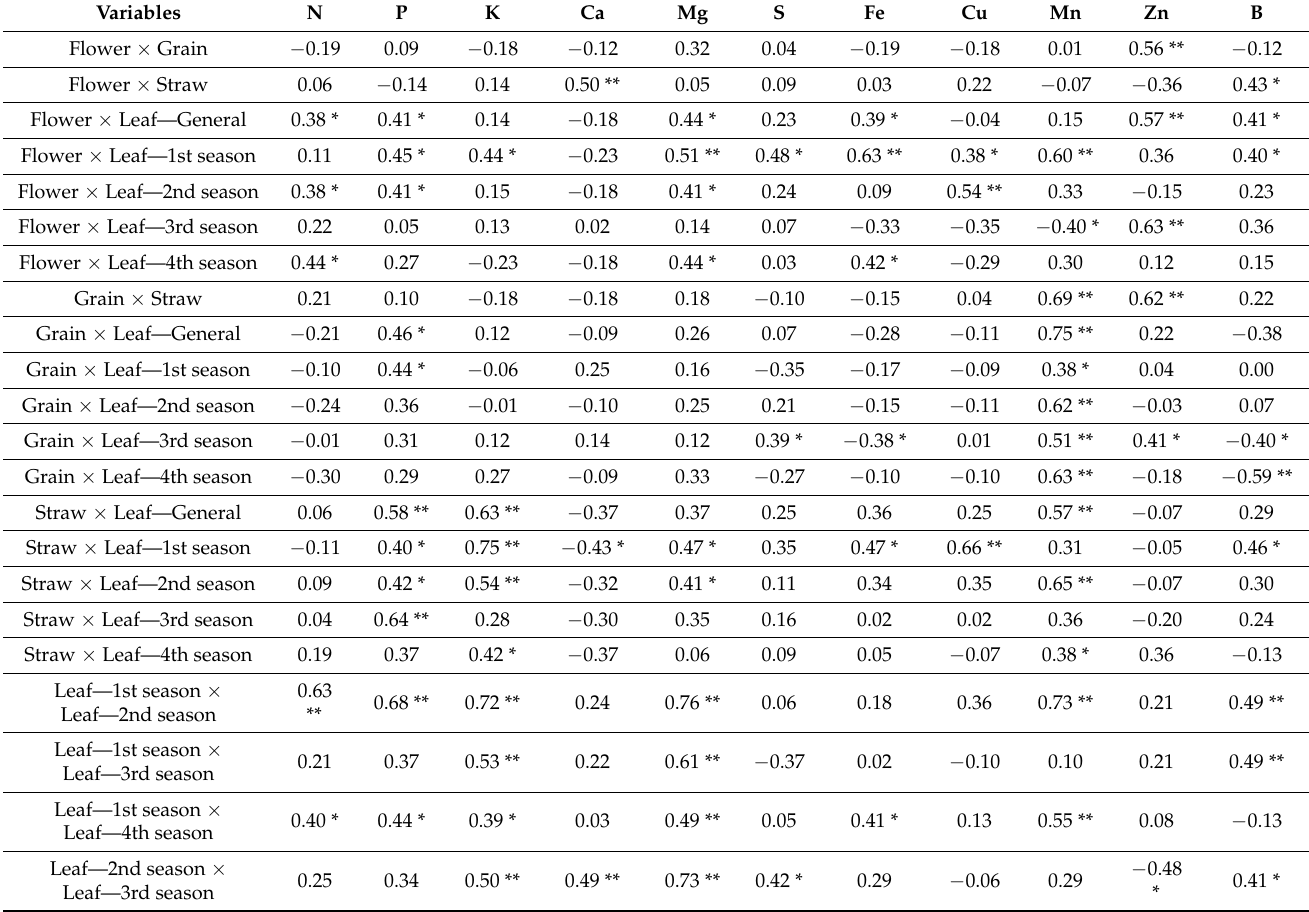
Table 7. Spearman correlation coefficients for nutrient concentration in flowers, grains, straw, and leaves of Coffea canephora genotypes. S ã o Mateus, state of Esp í rito